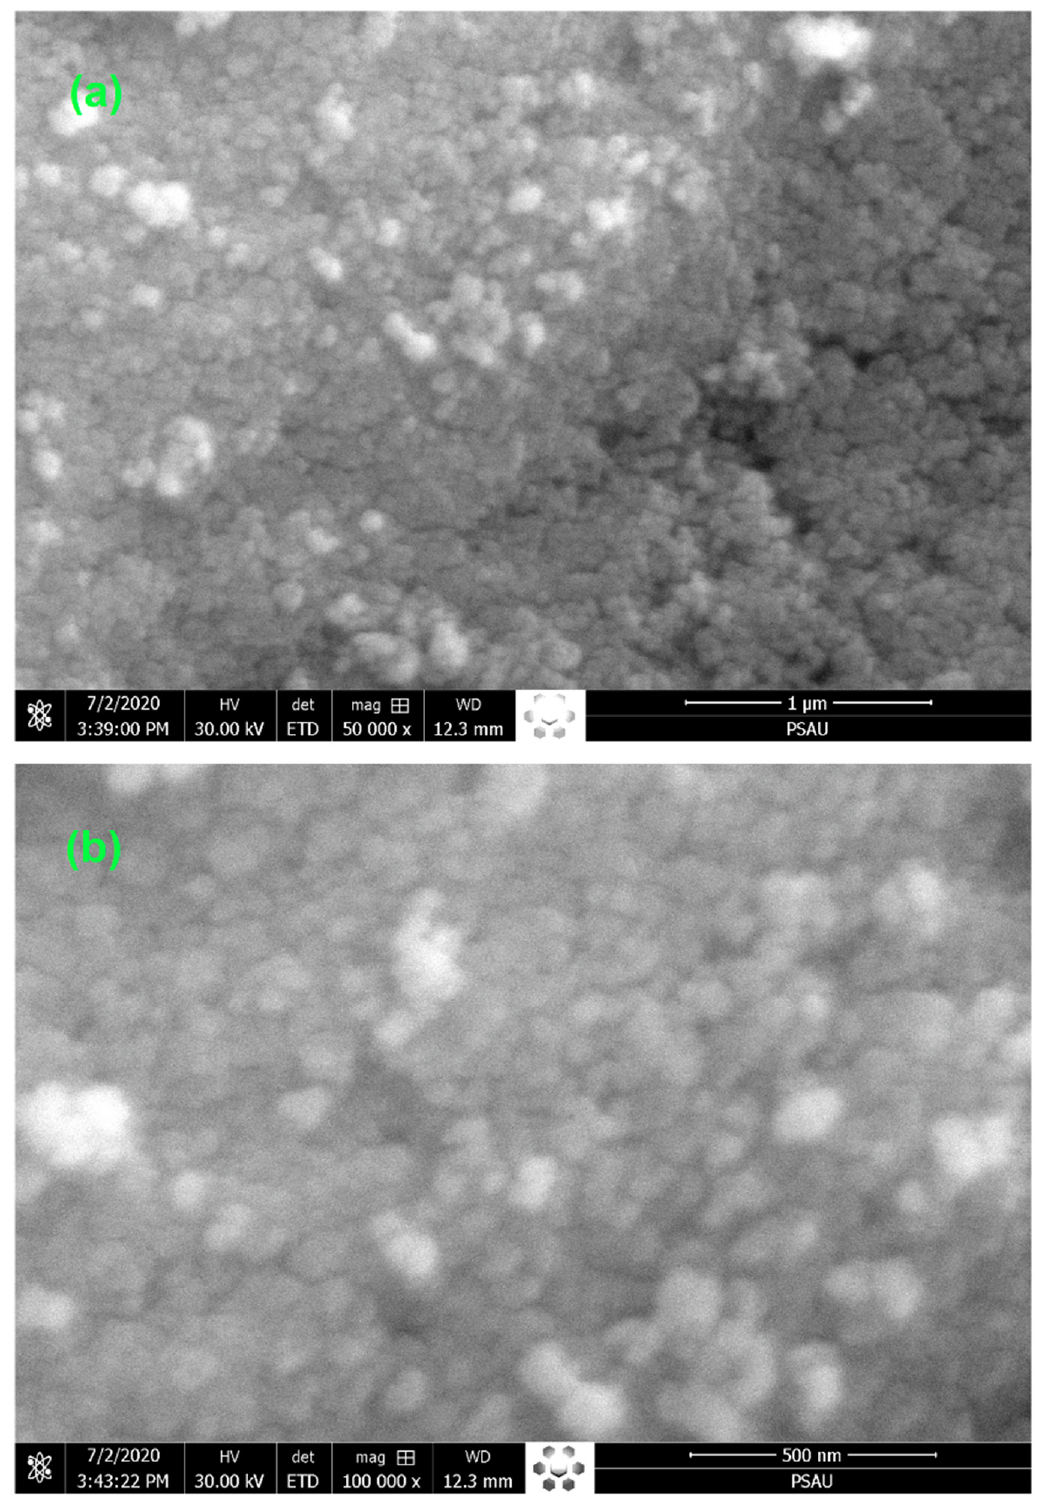
Figure 1. FESEM micrograph of the as-synthesized TiO 2 nanoparticles at ( a ) lower and ( b ) higher magnification.